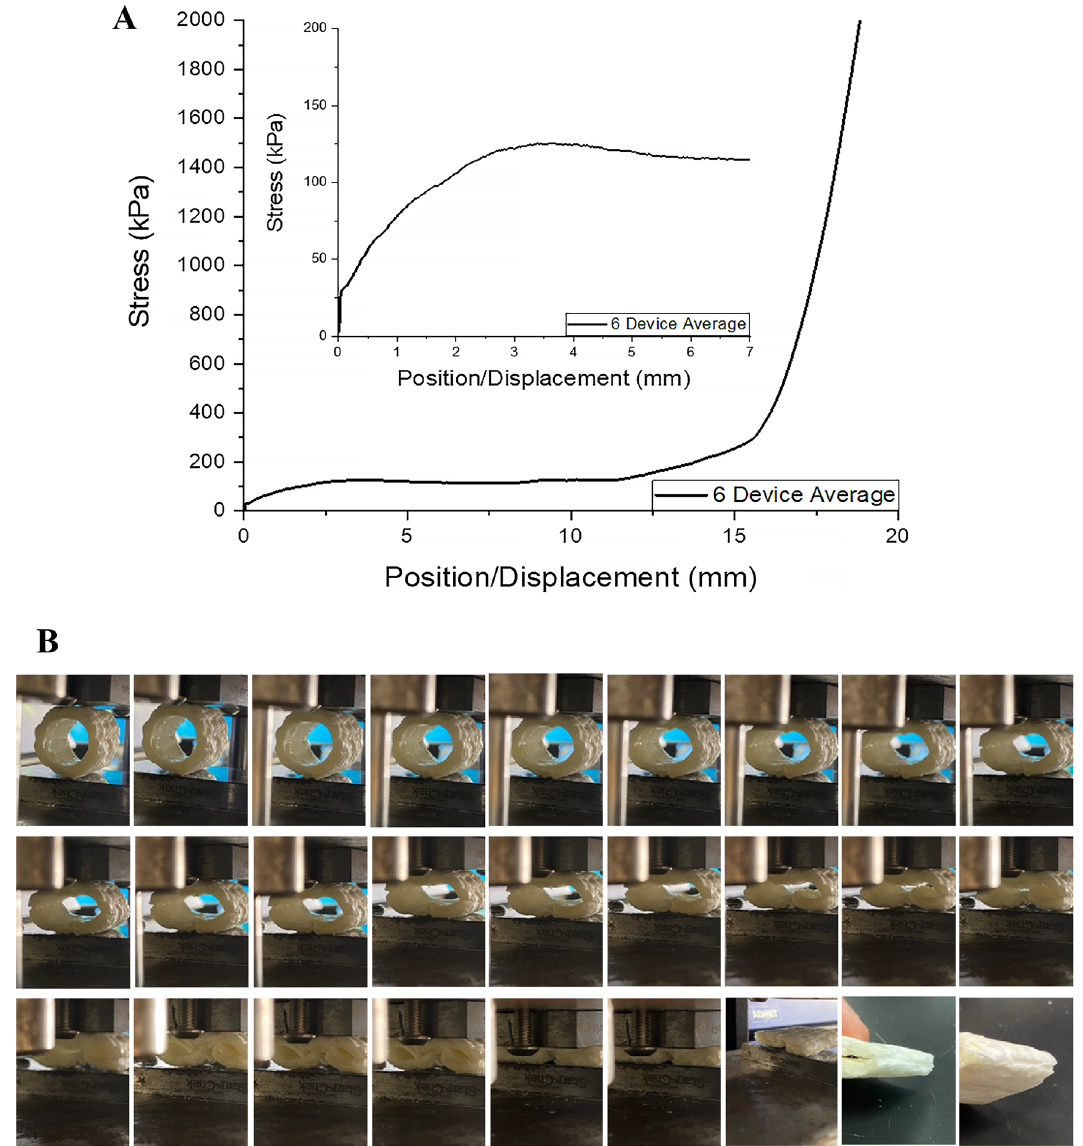
Figure 5. Mechanical compression results: ( A ) strain/displacement curve (average of 6 independent measurements)—the inset is the magnified part of the averaged curve for up to 7 mm displacement; ( B ) consecutive images collected during the compression of a device along with the final compressed image of the same device.